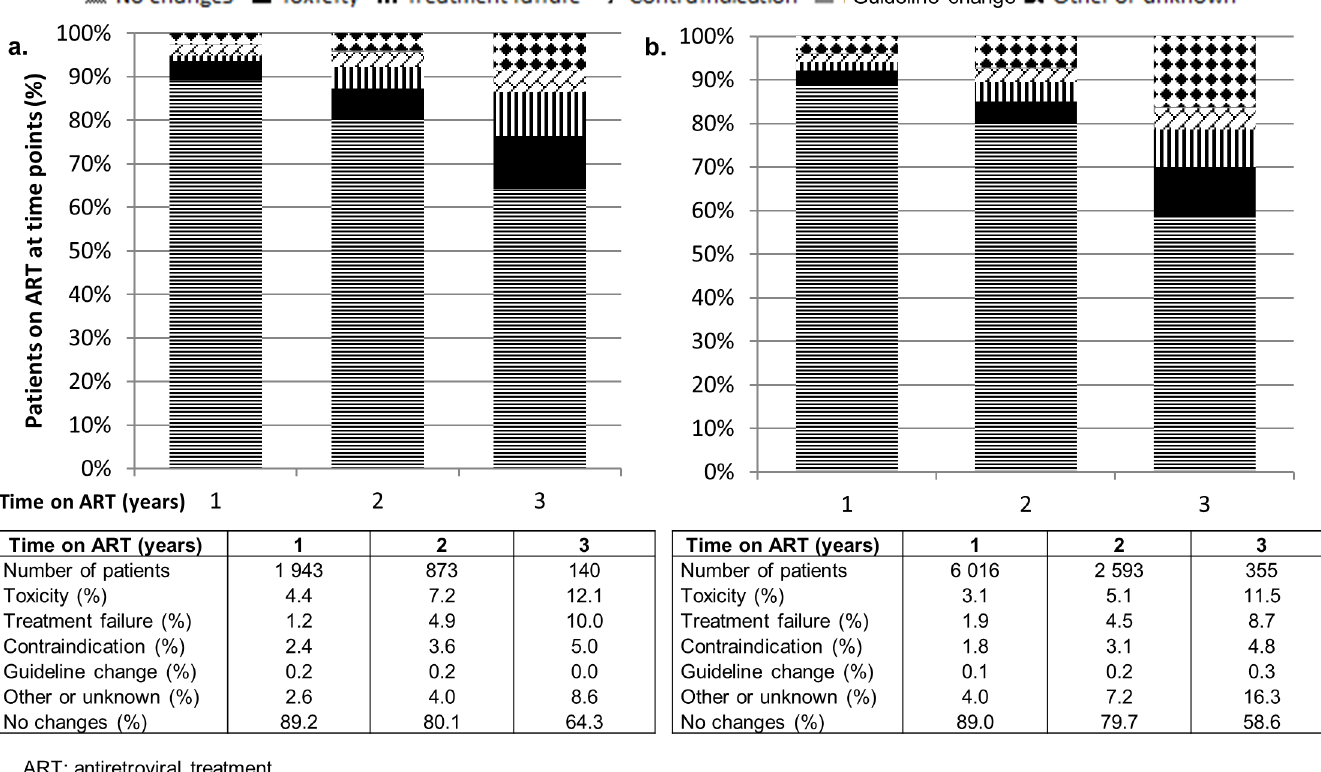
PLOS ONE | https://doi.org/10.1371/journal.pone.0203530 September 5,